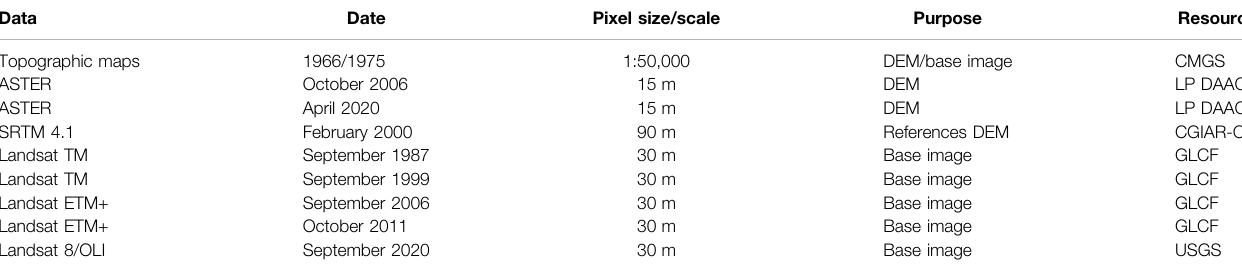
TABLE 1 | List of data for the glacier change assessment over the Turgen Daban